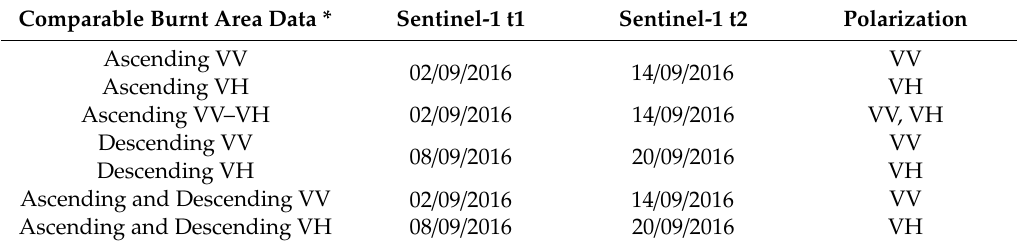
Table 2. Classifications carried out to Sentinel-1 images to create comparable